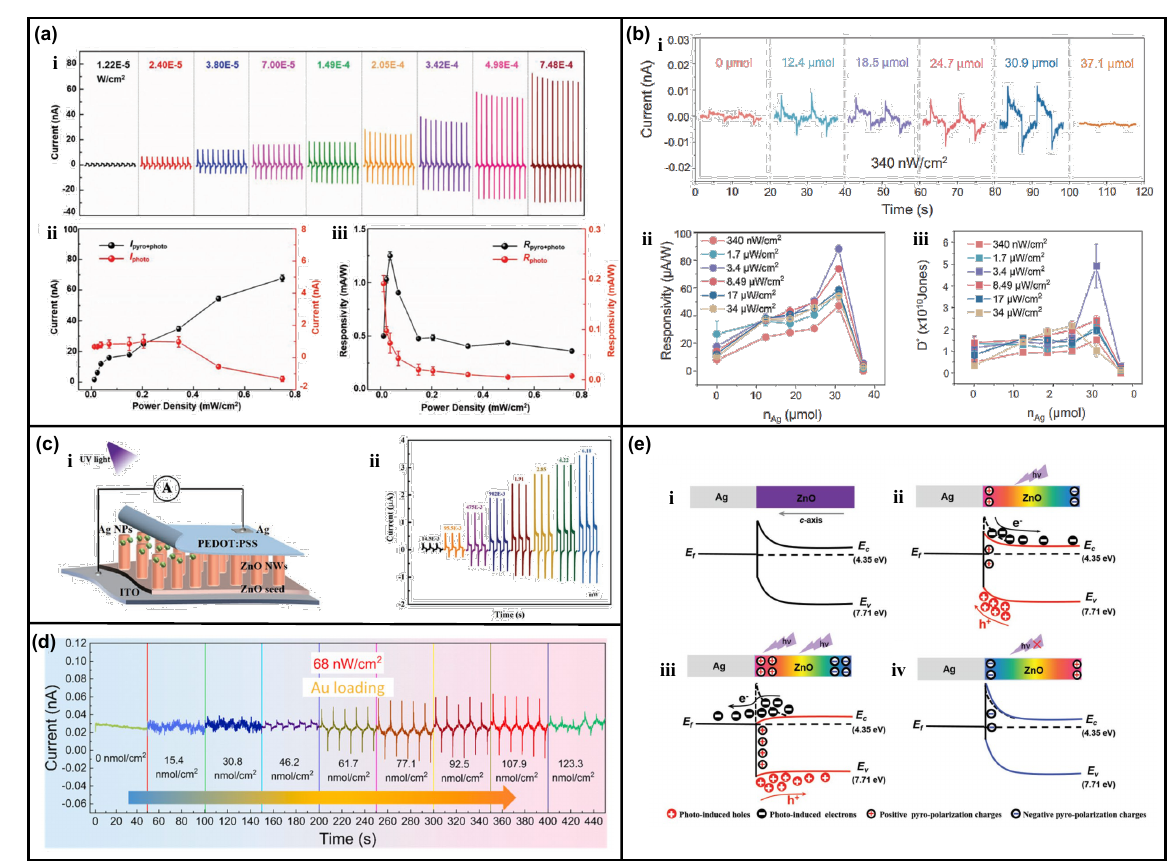
Figure 2. Photoresponse of photodetectors based on metal–ZnO contact. ( a ) Pyro-phototronic-effect-enhanced performances of the self-powered ZnO/Ag Schottky junction photodetector. ( ⅰ ) I–t characteristics of pyro-phototronic effect-based photodetector under 325 nm illuminations with different power densities; ( ⅱ ) The transient short-circuits current and the steady-state current as a function of the power density; ( ⅲ ) The corresponding photoresponsivity R pyro + photo and R photo as a function of the power density. Reproduced with permission from [28] Copyright 2018 Wiley; ( b ) The LSPR-enhanced performance of Ag–ZnO photodetectors on UV detection. ( ⅰ ) The I–t characteristic curves of Ag–ZnO photodetectors with different loadings of Ag NPs; ( ⅱ ) The responsivity of the Ag–ZnO photodetectors changed as the loading of Ag NPs increases under different power densities; ( ⅲ ) The detectivity of the Ag–ZnO photodetectors varied as the loading of Ag NPs increased under various power densities. Reproduced with permission from [29] Copyright 2022 Wiley; ( c ) Structure and I–t characteristics of the self-powered Ag NPs/ZnO nanowires/PEDOT:PSS photodetector under 325 nm light with various power intensities. Reproduced with permission from [30] Copyright 2022 Wiley; ( d ) The I-t dynamic response characteristics of Schottky junction based on Au NPs@ZnO NW under the illumination of 325 nm light with a power density of 68 nW/cm 2 . Reproduced with permission from [31] Copyright 2022 Wiley; ( e ) Energy band diagrams of the flexible self-powered ZnO/Ag Schottky junction under the conditions of ( ⅰ ) dark; ( ⅱ ) the weak illumination; ( ⅲ ) the strong illumination; and ( ⅳ ) withdrawing illumination. Reproduced with permission from [28] Copyright 2022 Wiley. Not only the Ag metal could be utilized to form an Ag/ZnO nanowires Schottky junction, but Ag or Au nanoparticles could also be applied to ZnO nanowires for decoration, forming the Schottky junction and introducing the localized surface plasmon resonance (LSPR) at the same time [29,31]. The ZnO nanowires are grown through the hydrothermal method on FTO/glass substrate, and then Ag or Au nanoparticles are decorated onto the ZnO nanowires by sputtering and careful control of sputtering parameters. Compared to